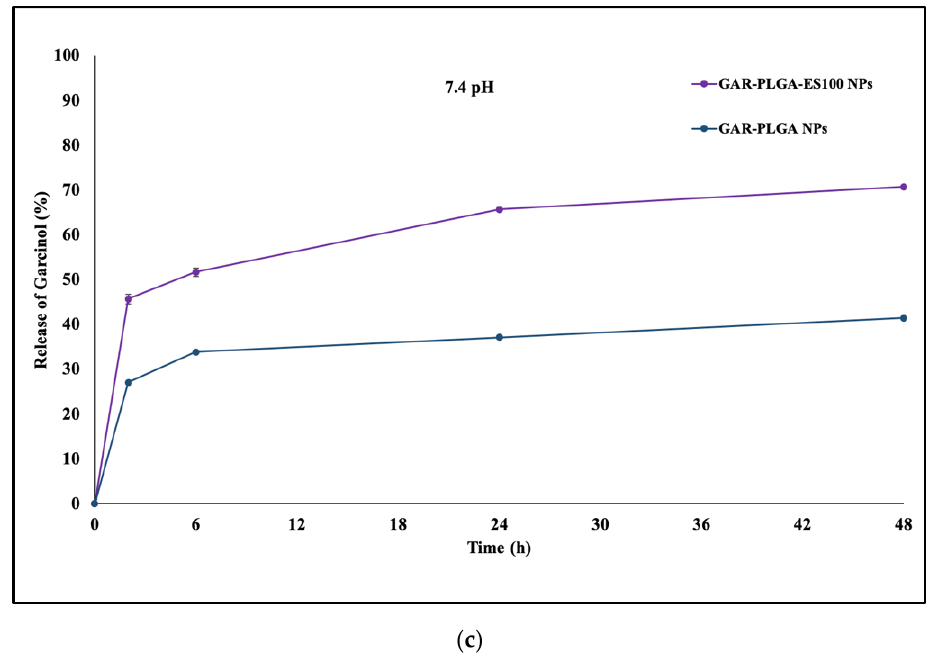
Figure 3. ( a ) In vitro release of GAR from GAR-PLGA-ES100 NPs and GAR-PLGA NPs in phos- phate buffered saline (PBS) (pH 1.2, PBS/FBS buffer) studied over 2 days at 37 °C. ( b ): In vitro re- lease of GAR from GAR-PLGA-ES100 NPs and GAR-PLGA NPs in PBS (pH 5.6, PBS/FBS buffer) studied over 2 days at 37 °C. ( c ): In vitro release of GAR from GAR-PLGA-ES100 NPs and GAR- PLGA NPs in PBS (pH 7.4 PBS/FBS buffer) studied over 2 days at 37 °C.